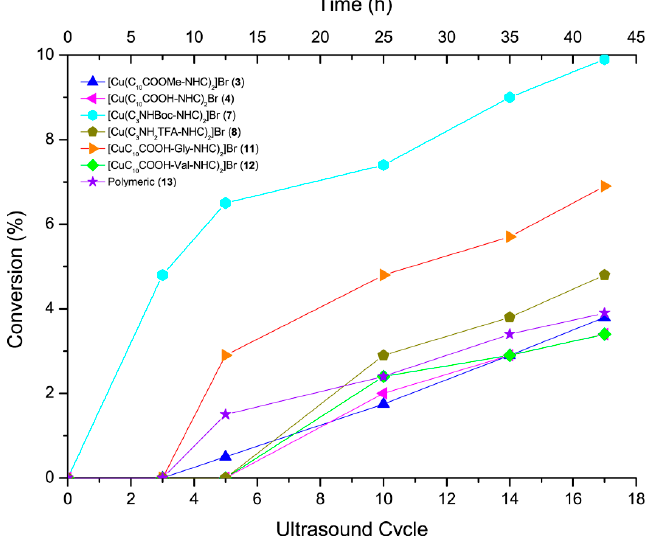
Figure 7. Percentage of conversion of phenylacetylene ( 15 ) and benzyl azide ( 14 ) to the “clicked” product 16 as calculated from 1 H NMR spectroscopy with a standard deviation of ±1%. Samples were taken after the cycles 0, 3, 5, 10, 14, and 17.